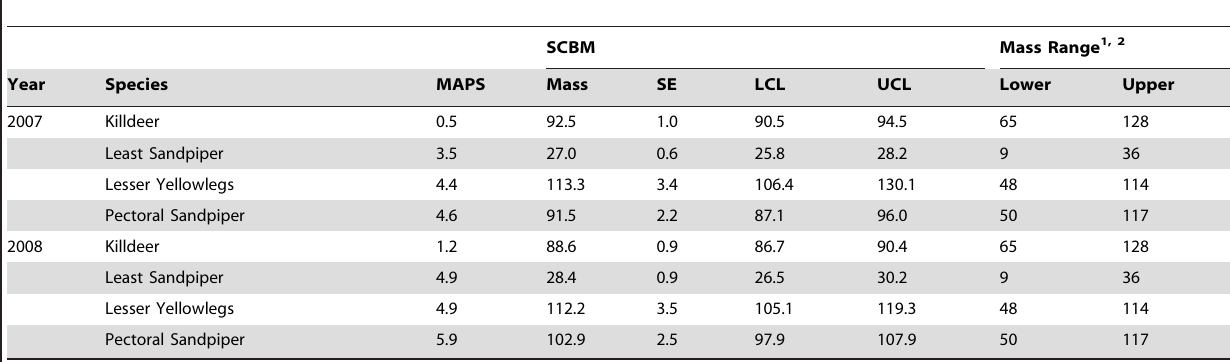
Table 2. Mean MAPS score (0–7), size-corrected body mass (SCBM; grams), standard error (SE), and 95% lower and upper confidence limits (LCL and UCL) of shorebirds collected in central Illinois during fall migrations 2007 and 2008, and published mass ranges (grams) for target